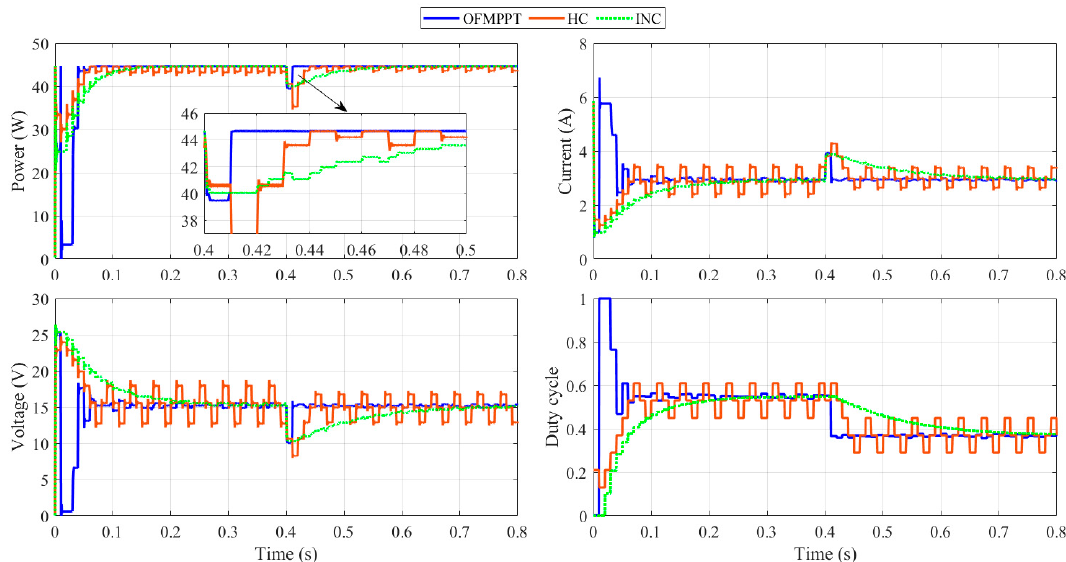
Figure 14. Dynamic tracking performance using OFMPPTS, HC, and INC methods for 5th scenario.